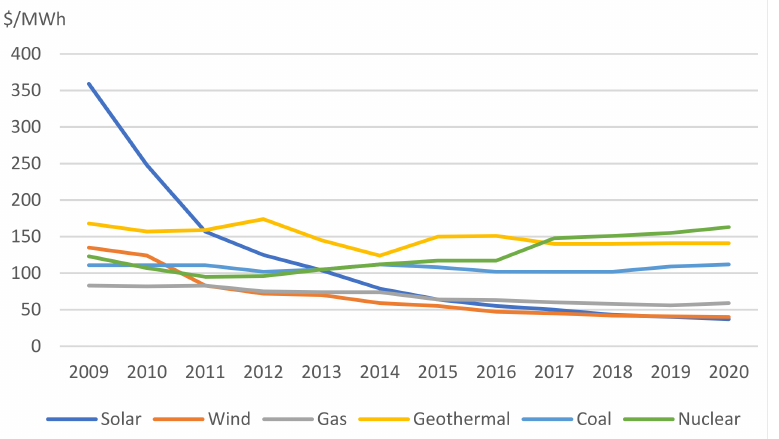
Figure 5. Change dynamics of production costs of 1 MWh. Source: Own elaboration based on